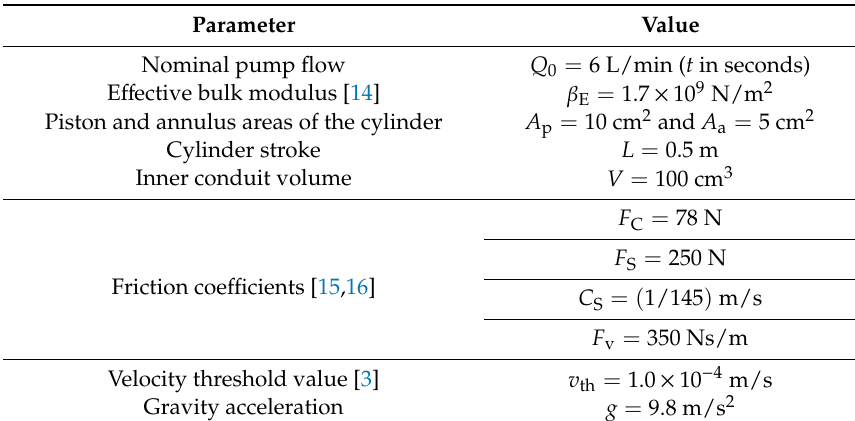
Table 1. Basic data used in the numerical simulations.